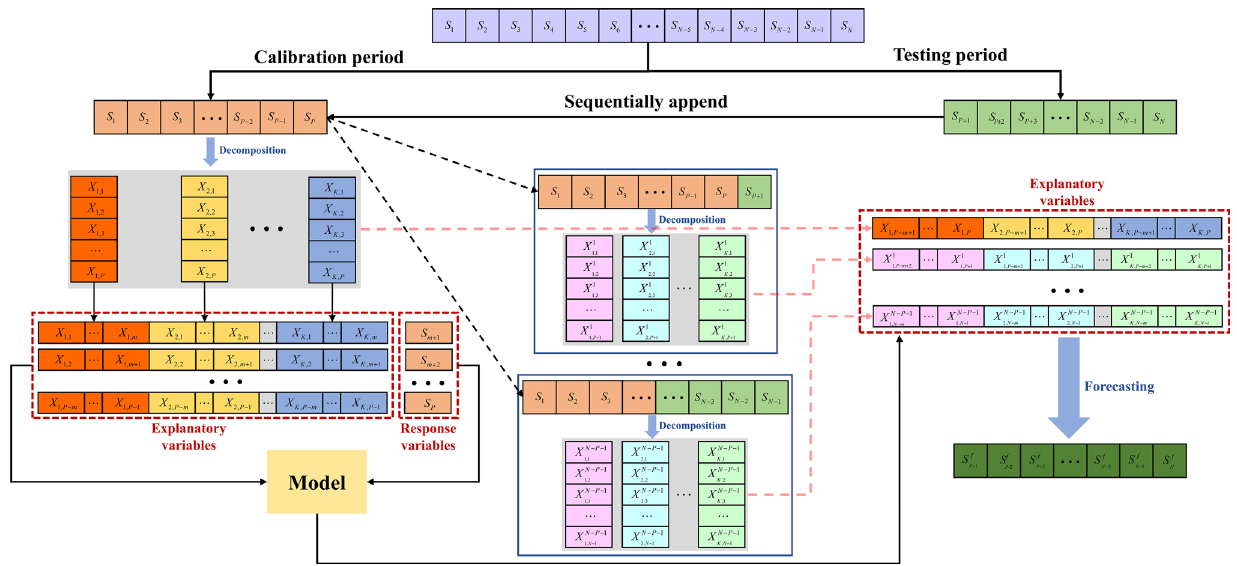
Fig. 4 The process of SMSSD sampling